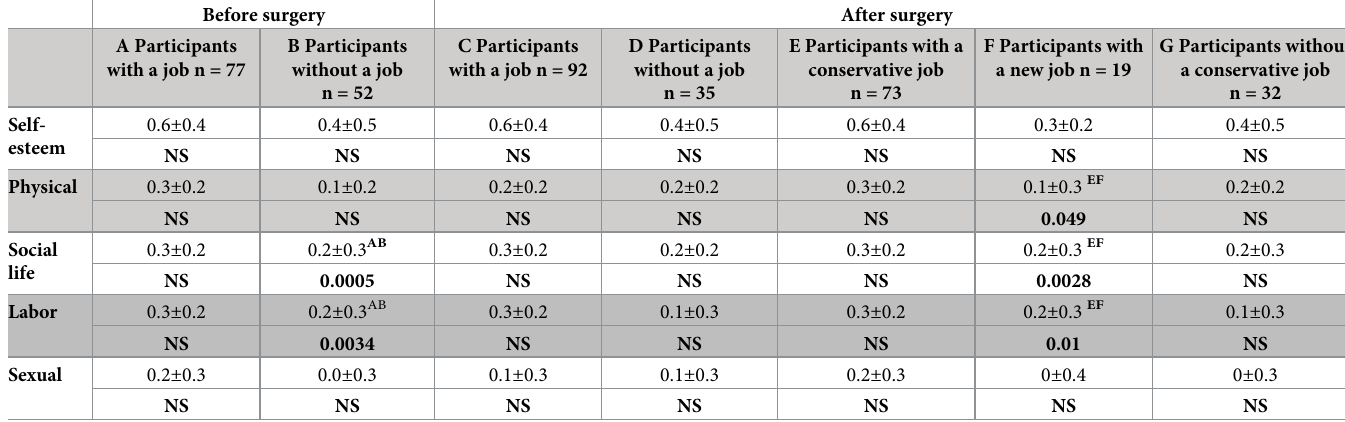
BMI = body mass index; EPICES = Evaluation of Deprivation and Inequalities in Health Examination Centers; BAROS = Bariatric Analysis and Reporting Outcome System. NS means non significant by comparison between groups before or after surgery Only statistically significant differences were indicated between